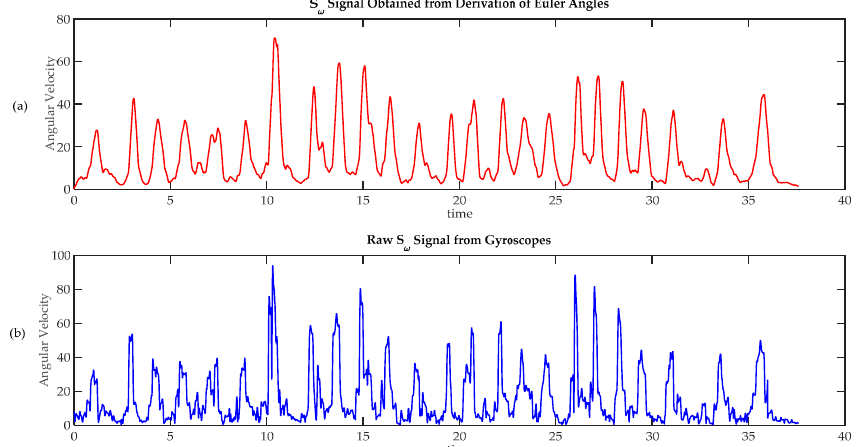
Figure 11. Comparison of techniques to calculate angular speed. ( a ) Angular velocity calculated from absolute orientation angles φ , θ and ψ , obtained using a sensor fusion algorithm; ( b ) Angular speed calculated from raw gyroscope data.